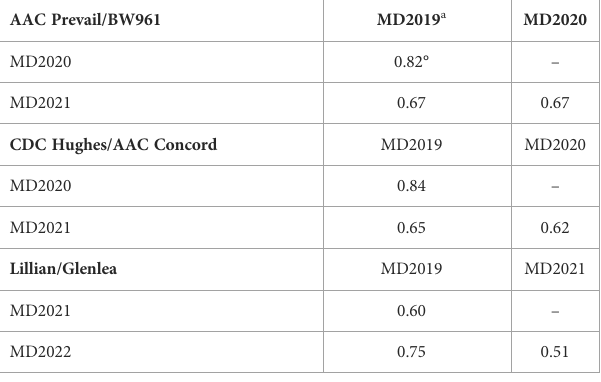
TABLE 2 Pearson correlation coef fi cients ( r ) between leaf rust severity for different environments in three